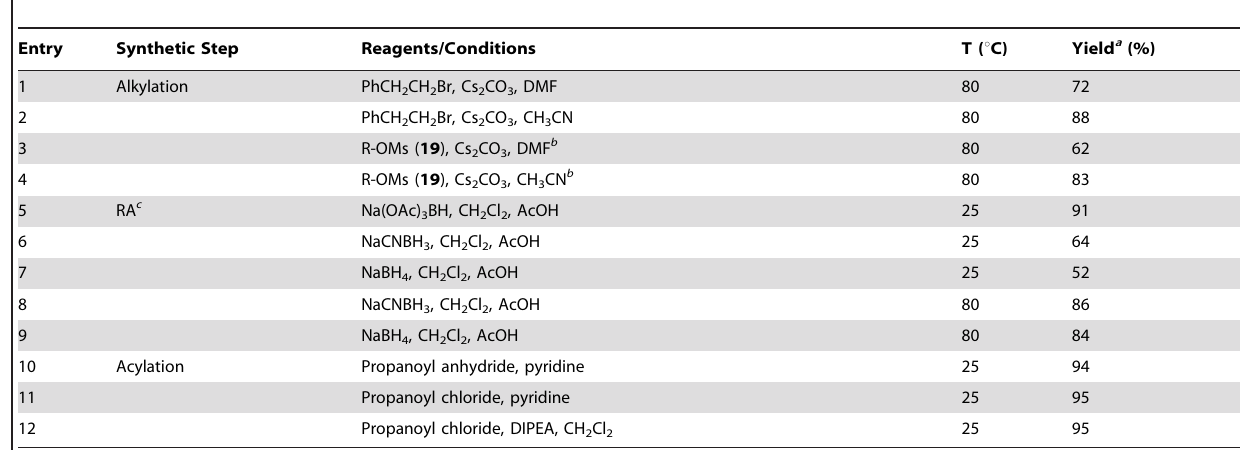
Table 1. Optimization steps for the synthesis of fentanyl ( 4 ); a isolated yield; b alkylation in the synthesis of thiofentanyl derivatives; c reductive